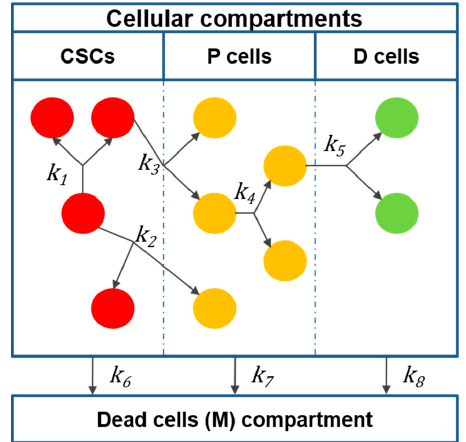
Figure 1. Compartmentalized representation of the proposed model. Each cell event is mediated by a rate constant k j . Cancer stem cells (CSCs) can self-renew ( k 1 ) or give rise to intermediate progenitor (P) cells through either asymmetric ( k 2 ) or symmetric ( k 3 ) division. P cells, in turn, can proliferate ( k 4 ) and give rise to terminally di ff erentiated (D) cells ( k 5 ). Each cell type has a death rate represented by k 6 for CSCs, k 7 for P cells, and k 8 for D